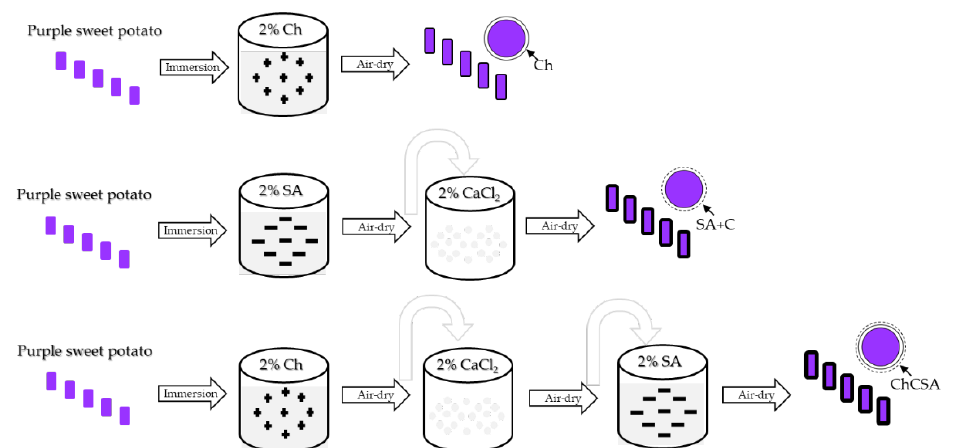
Figure 11. Illustration of coating procedure for fresh-cut purple flesh sweet